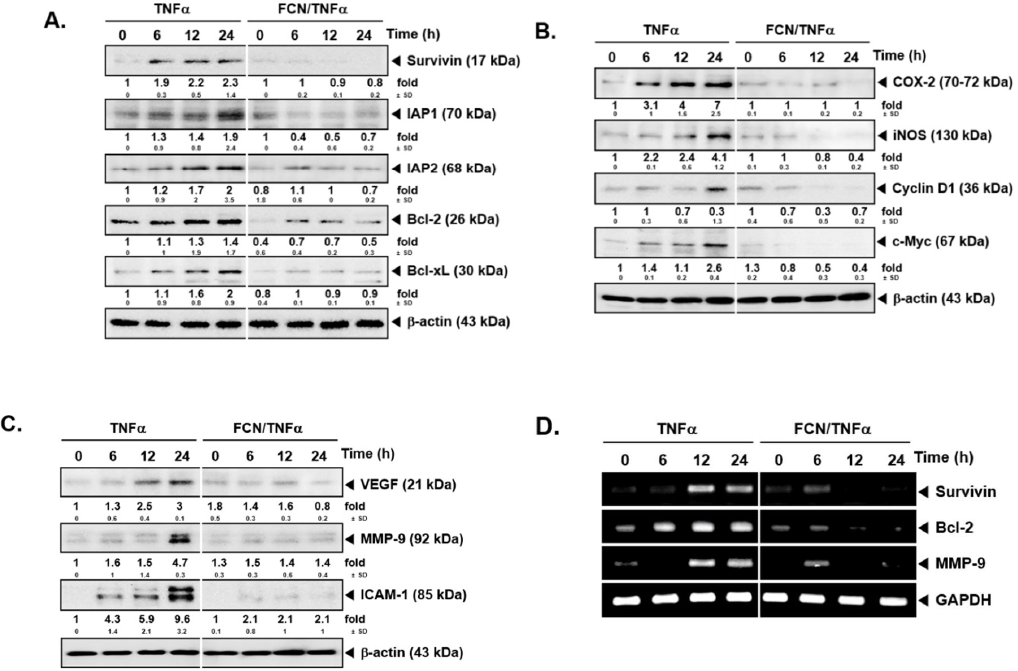
Figure 3. FCN influences the expression of various oncogenic genes. KBM5 cells were pre-treated with 15 μM of FCN for 2 h. After 2 h, 0.5 nM TNFα was added for 24 h. ( A ) Western blot analysis was performed to check the expression of various proteins. ( B ) The levels of proliferative gene products were analyzed by Western blot analysis. ( C ) The expression of metastatic gene products were analyzed by Western blot analysis. ( D ) RT-PCR was done to check the mRNA level of various genes.